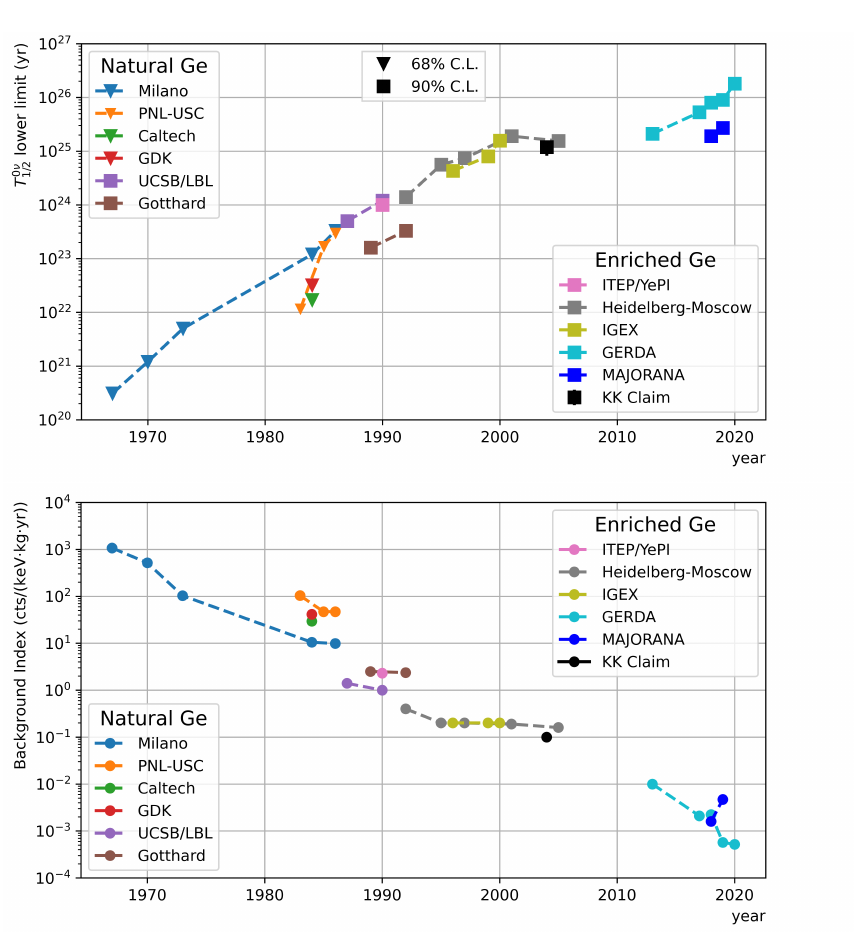
Figure 4. Evolution of the lower limit on the half-life ( upper panel) and background index ( bottom panel) as a function of time for the experiments searching for 76 Ge 0 νββ decay. References are in the text (see Section